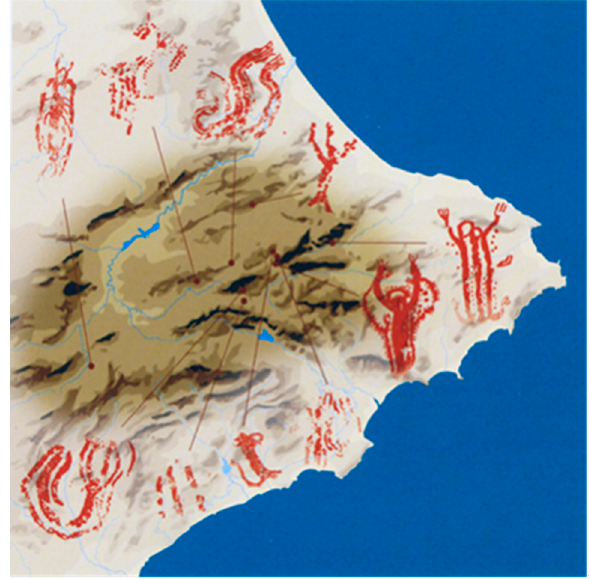
Figure 18. Macroschematic art in the province of Alicante. Source: (Hernández Pérez 2016, p. 483).